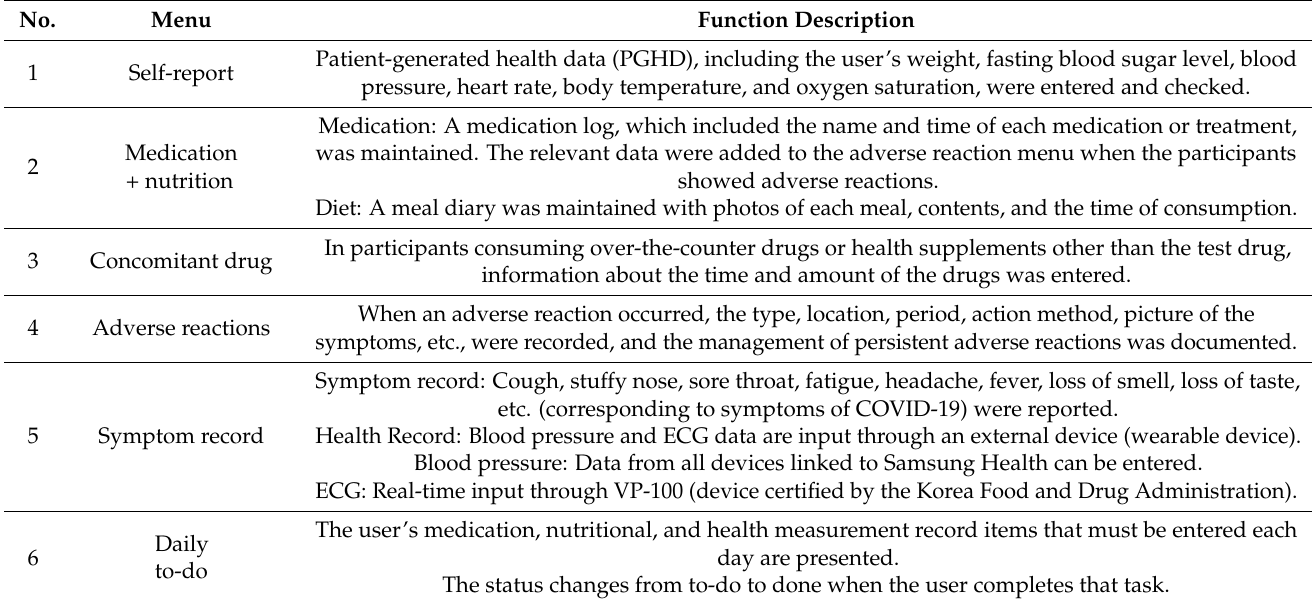
Table 2. Confirmed main menu structure and